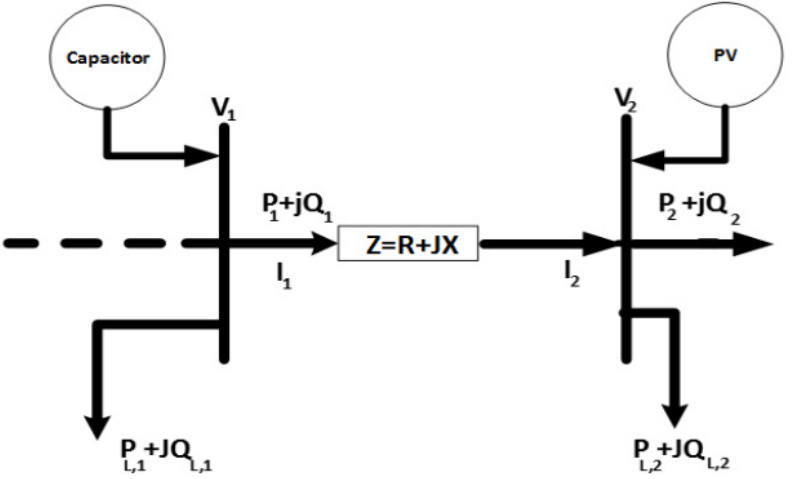
Figure 1. Representation of two buses in a distribution network.